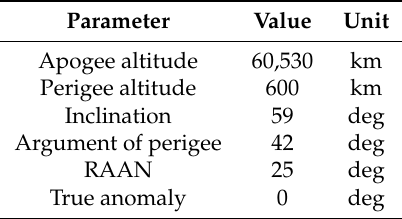
Table 2. Highly elliptical formation flying demonstration (HEFFD) mission orbit parameters (master